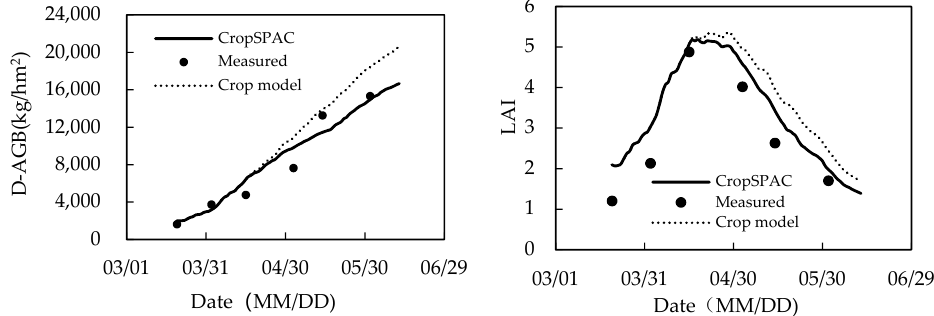
Figure 16. Comparison between CropSPAC and crop module simulated D-AGB and LAI in W0 treatment.